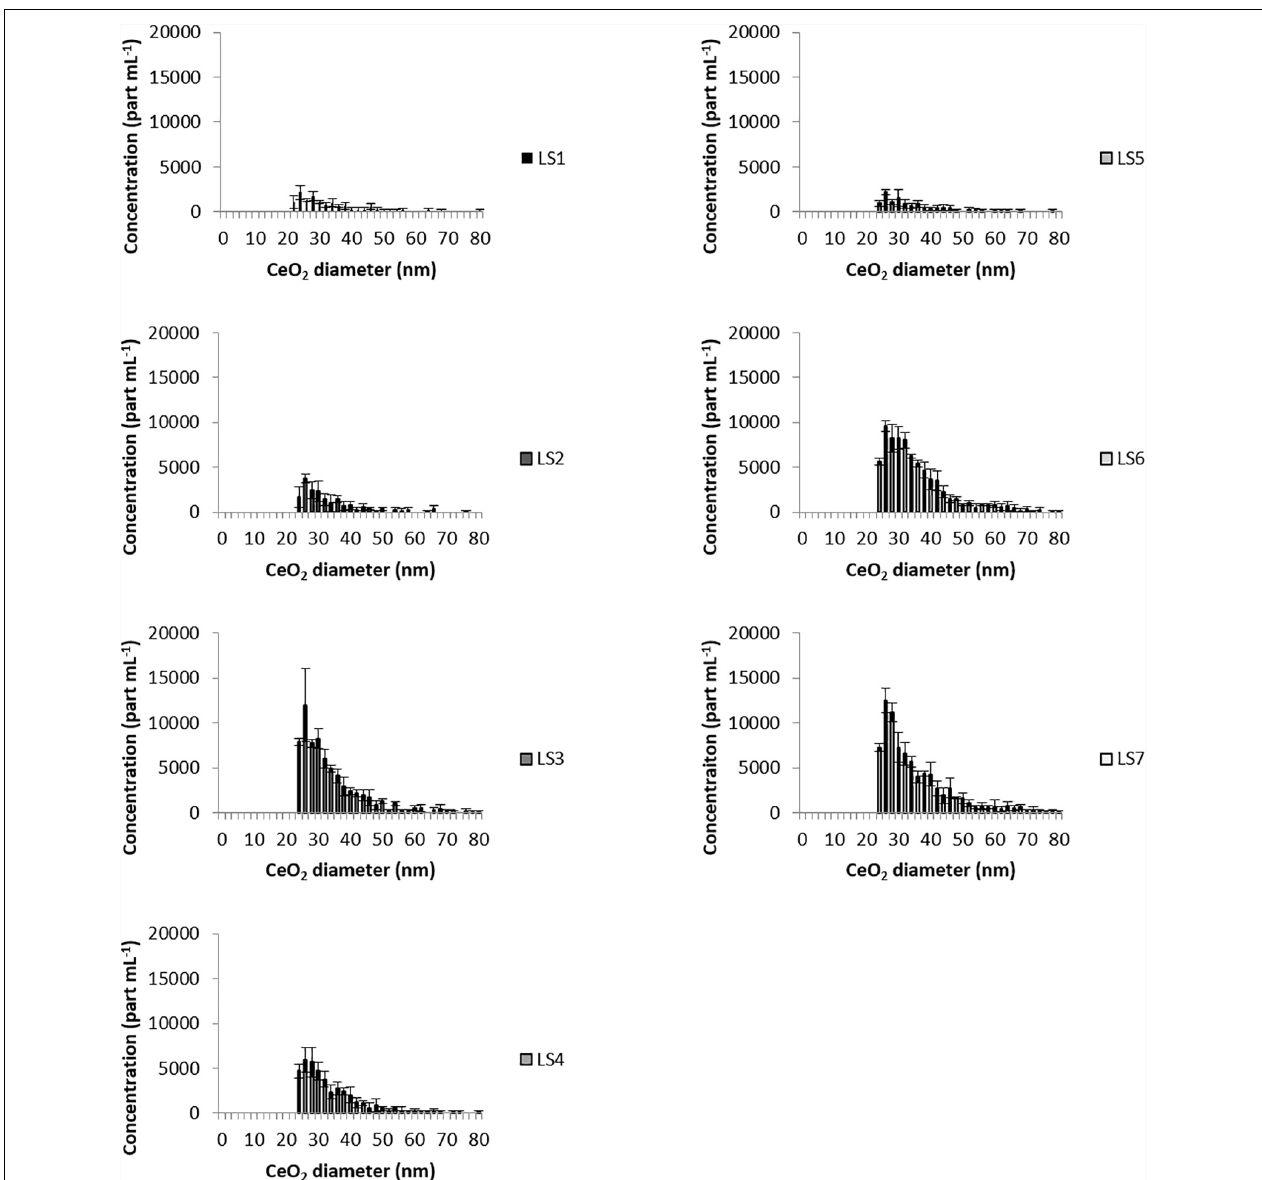
FIGURE 3 | Size distribution of CeO 2 NPs in Loire River water